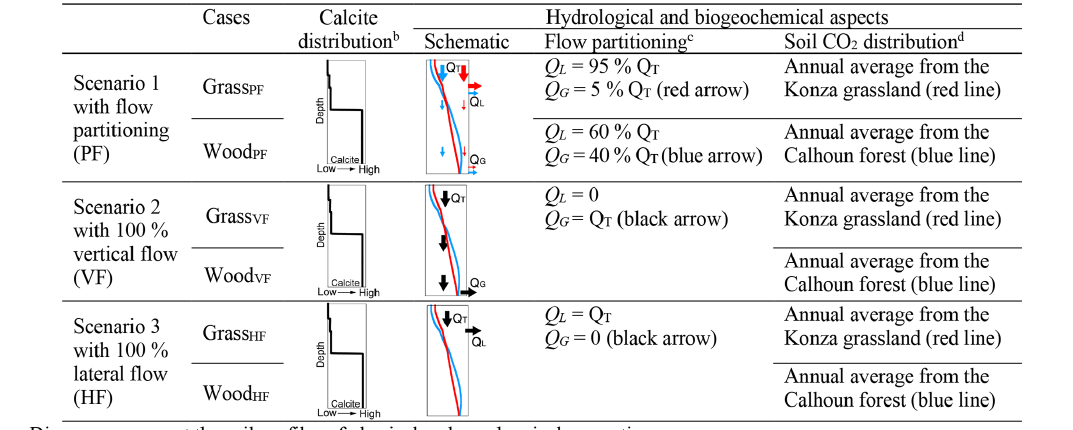
Table 3. Physical and geochemical characteristics in numerical